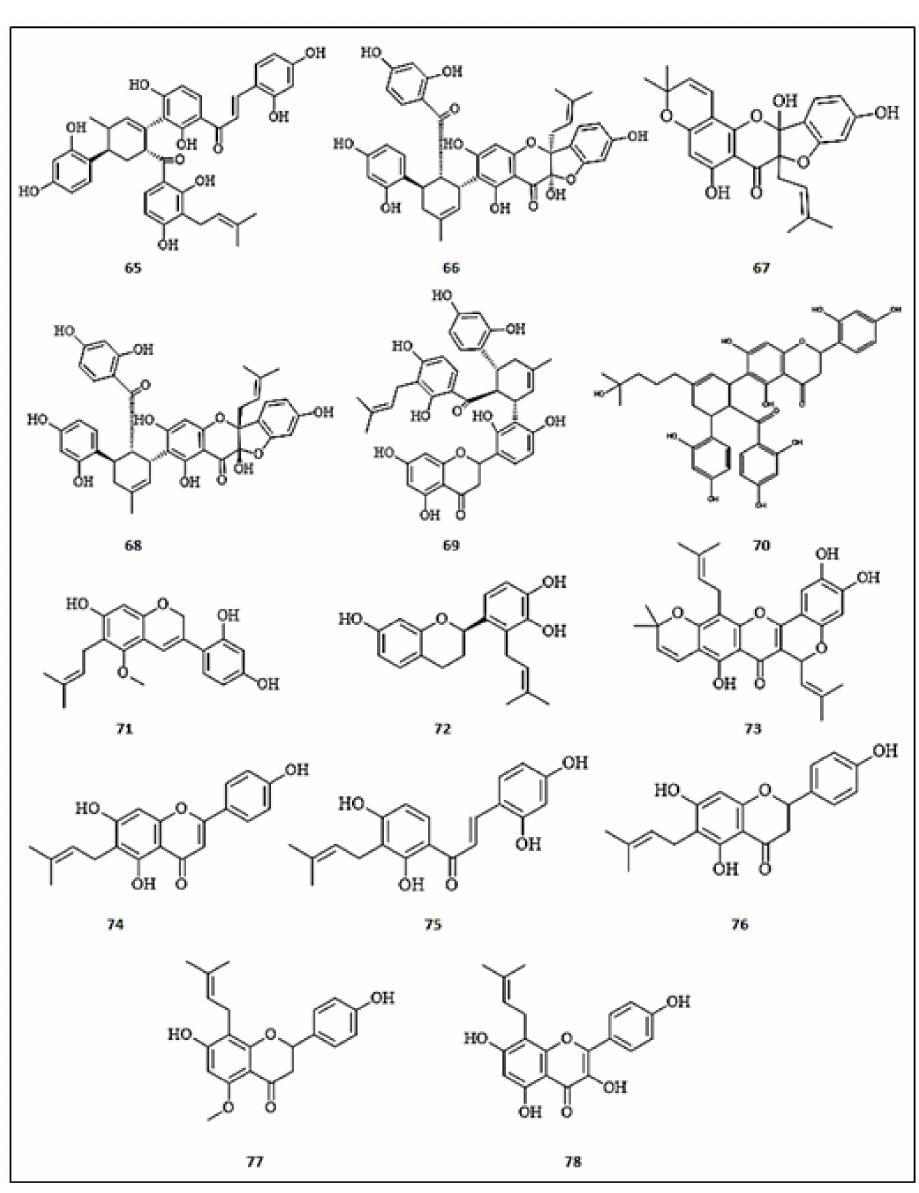
Figure 8. Chemical structures of prenylated flavonoids with anti-tyrosinase activity. ( 65 ) Kuwanon J; ( 66 ) Sanggenon C; ( 67 ) Sanggenon M; ( 68 ) Sanggenon O; ( 69 ) Kuwanon O; ( 70 ) Sanggenon T; ( 71 ) Dehydroglyasperin C; ( 72 ) Kazinol U; ( 73 ) Cycloheterophyllin; ( 74 ) Morachalcone A; ( 75 ) 6- prenylapigenin; ( 76 ) 6-Prenylnaringenin; ( 77 ) Isoxanthohumol; ( 78 )